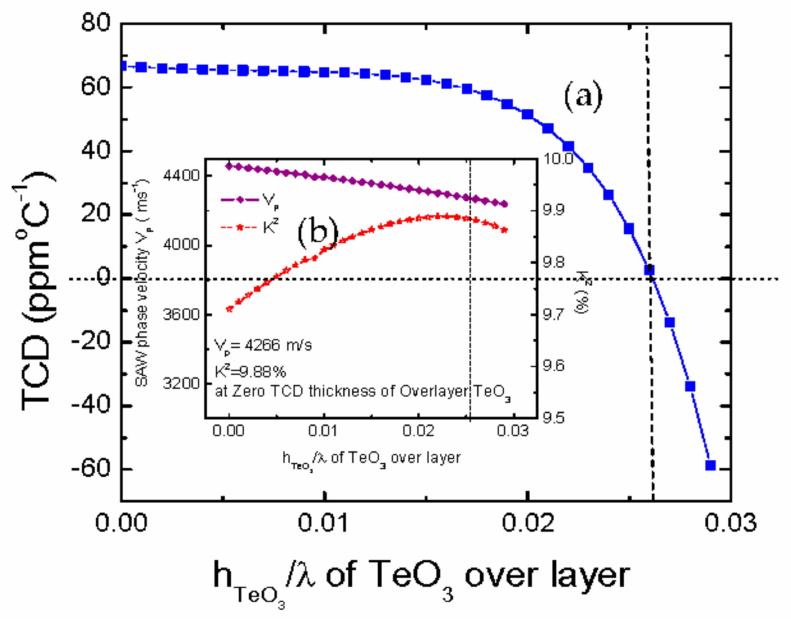
Figure 4. ( a ): Variation of TCD of TeO 3/ BeO(0.08 λ )/128 ◦ YX LiNbO 3 SAW structure with normalized thickness of TeO 3 over layer. ( b ) Variation of phase velocity and K 2 for TeO 3/ BeO(0.08 λ )/128 ◦ YX LiNbO 3 SAW structure with normalized thickness of TeO 3 over